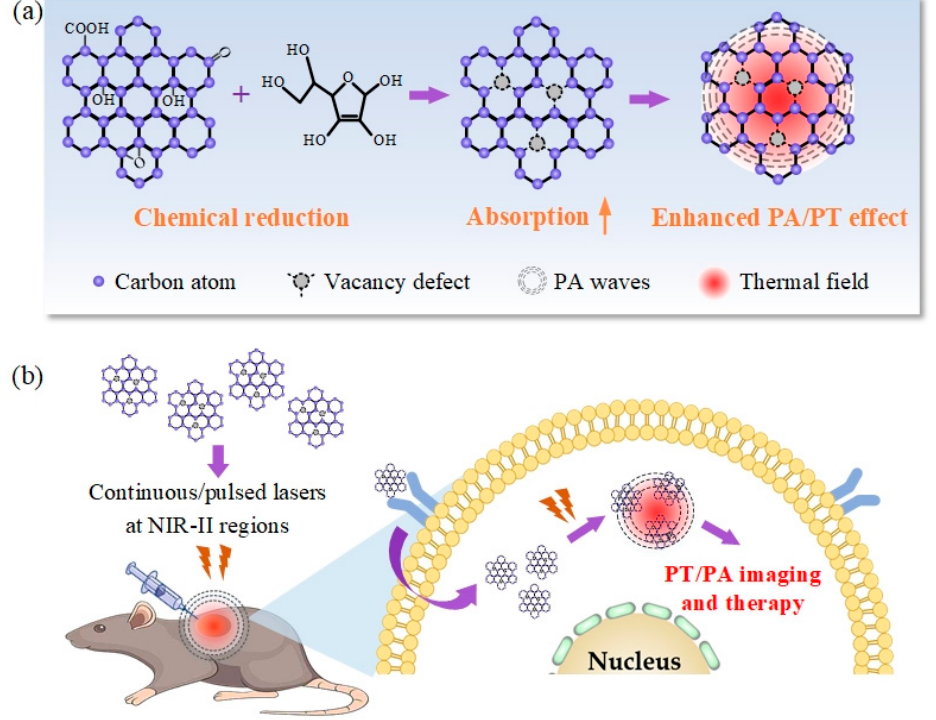
Figure 1. ( a ) The schematic diagram of chemically constructing chemically-reduced graphene oxide (CR-G) with enhanced photothermal (PT) and photoacoustic (PA) performances. ( b ) The PT/PA applications of CR-G nanomaterials in NIR-II biowindow.